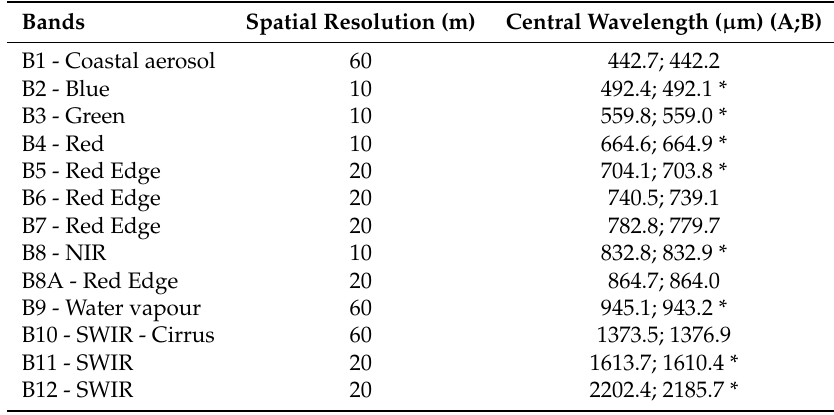
Table 2. Spectral bands of the Sentinel-2 mission. The central wavelength corresponds to the sensors on the Sentinel-2 satellites A and B. Source: Adapted from ESA [42]. Bands Spatial Resolution (m) Central Wavelength ( µ m) (A;B) B1 - Coastal aerosol 60 442.7; 442.2 B2 - Blue 10 492.4; 492.1 *